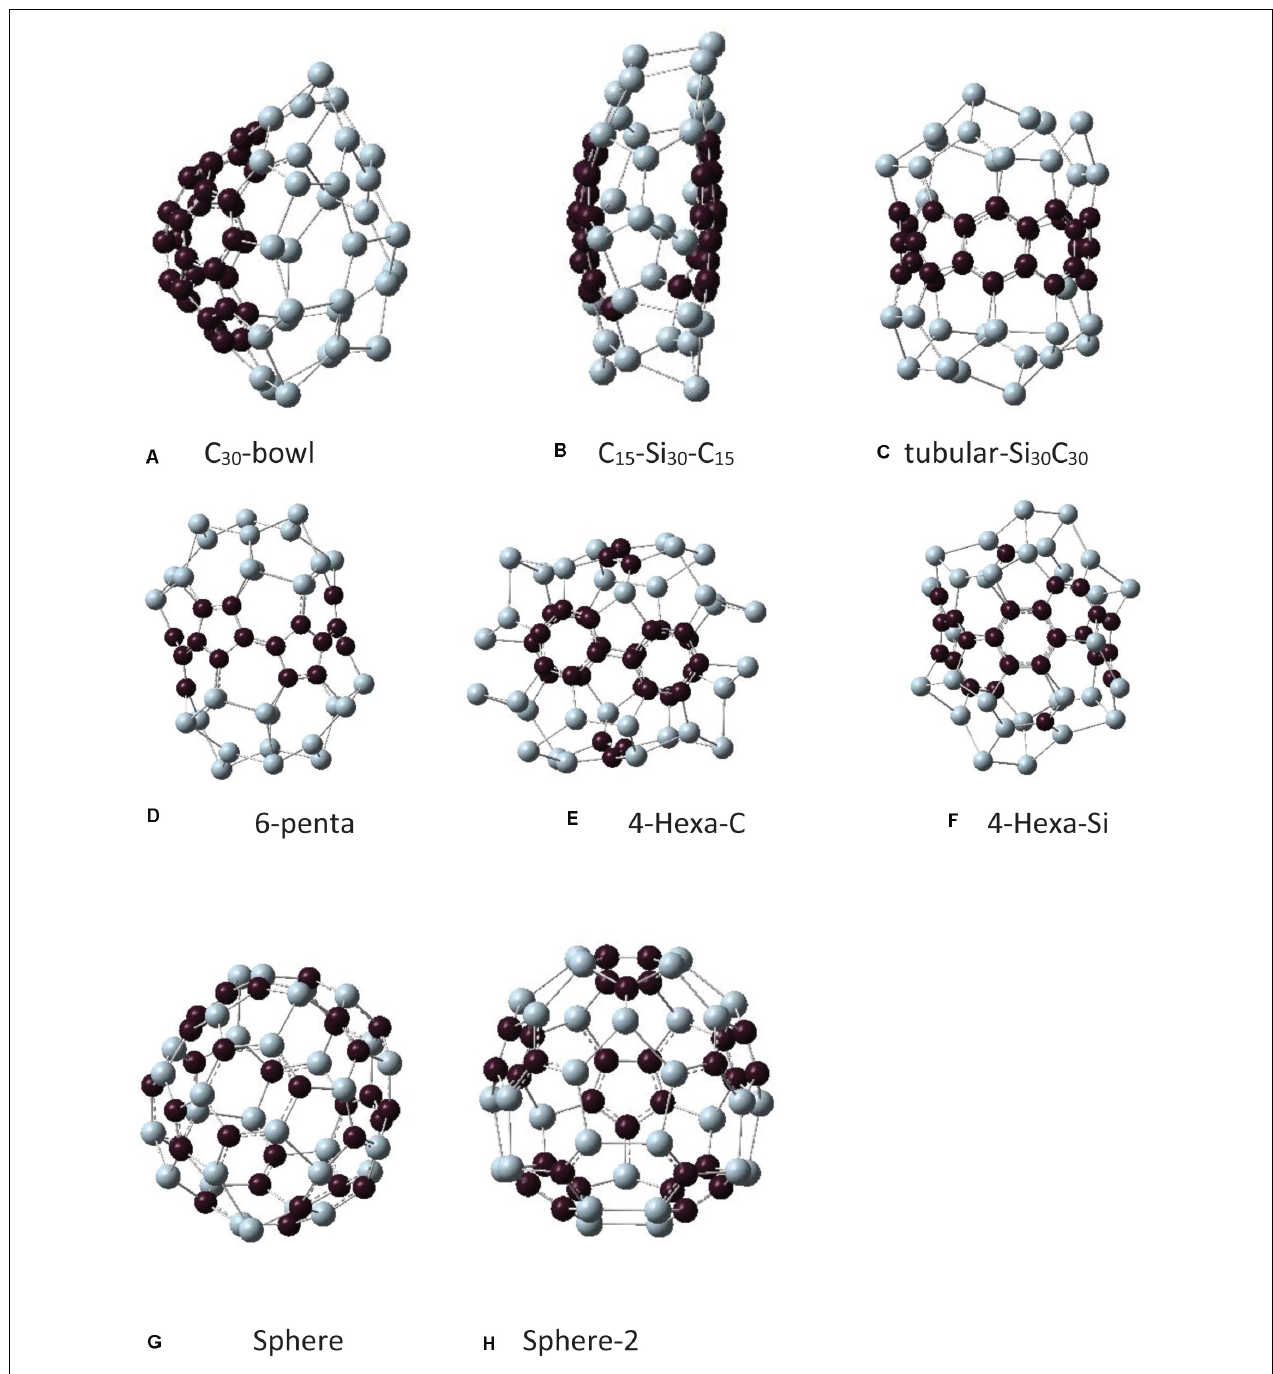
FIGURE 2 | Different isomers of the Si 30 C 30 structures obtained from Figure 1 and then relaxed completely without any symmetry constraint. The names of these structures are explained in the text. Structures are presented from panels (A–H) in order of their stability, most to least stable.